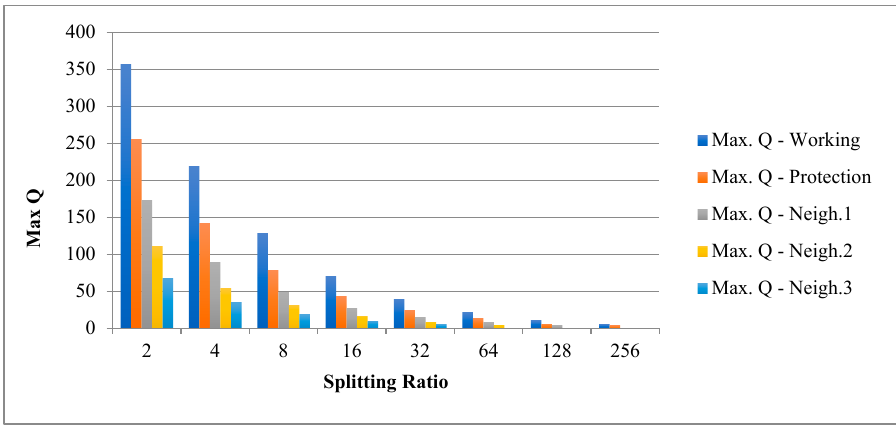
Figure 26. Received power and max Q factor recorded with the ‘zig-zag’ scheme by varying the splitting ratio.